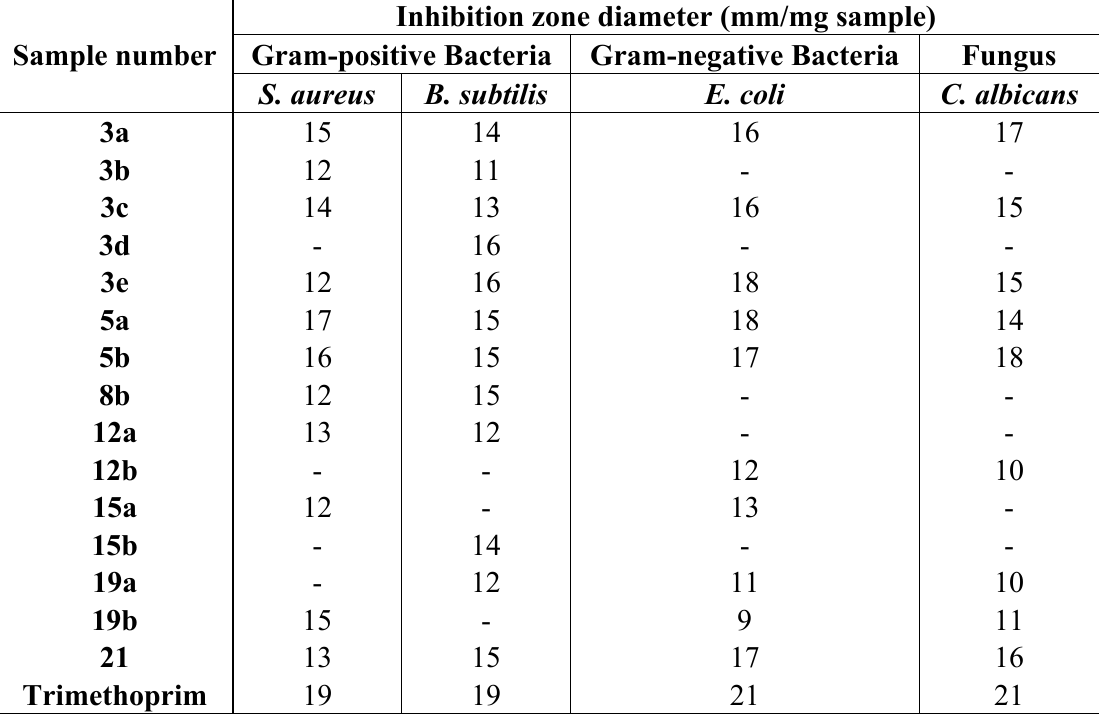
Table 1. Antimicrobial activity of the tested